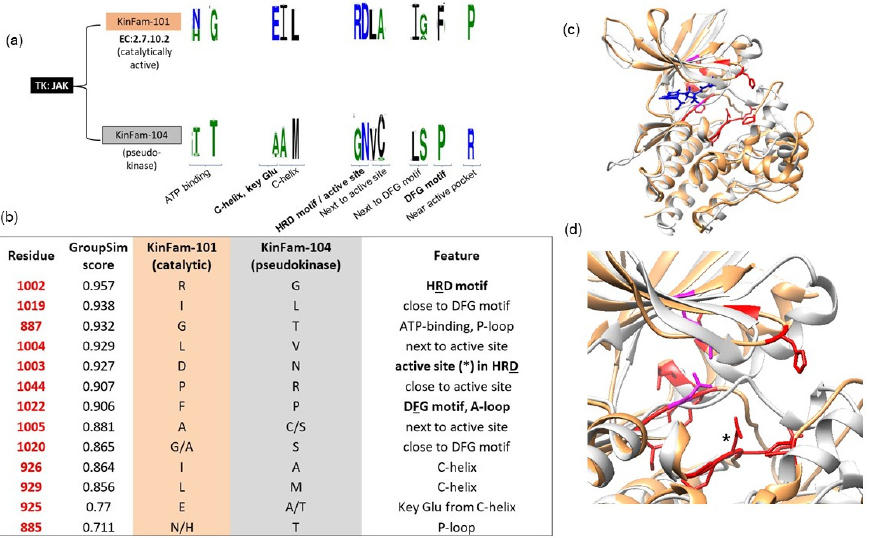
Figure 9. Specificity-determining positions (SDPs) predicted using CATH-KinFams: an example using the TK: JAK family. ( a ) TK: JAK family from KinBase is subdivided into two KinFams using CATH, each representing distinct kinases (catalytic and non-catalytic). ( b ) List of top-ranked SDPs (red) that are specific to each KinFam: 101 and 104: SDPs occur at/near the active site (within HRD motif in catalytic loop), at the DFG motif of the activation loop (residue numbering is shown according to the active kinase of JAK1, KinFam-101, PDB:6W8L). ( c ) Superposition of structures of the representatives of the catalytically active (orange, PDB: 6W8L, domain 875-1153) and pseudokinase (grey, AF_P23458, domain:583-855) of JAK1 (UniProt id: P23458). SDPs are shown in red. Ligand molecule from PDB:6W8L (namely R4S, which binds at the ATP-binding site), is shown in blue. ( d ) Close-up view of SDPs and their location within the catalytic and activation loops. Active site residue (D1003) in HRD motif is shown as asterisk. The other two active site residues are D1022 (from DFG motif) and K908 in the N-lobe (shown in magenta).